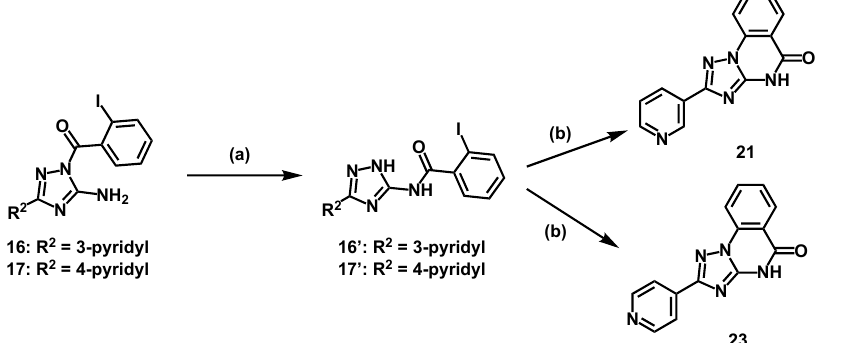
Scheme 3. Synthesis of [1,2,4]triazolo[1,5- a ]quinazolin-5(4 H )-ones 21 and 23 . ( a ) 260 ◦ C, 15 min,